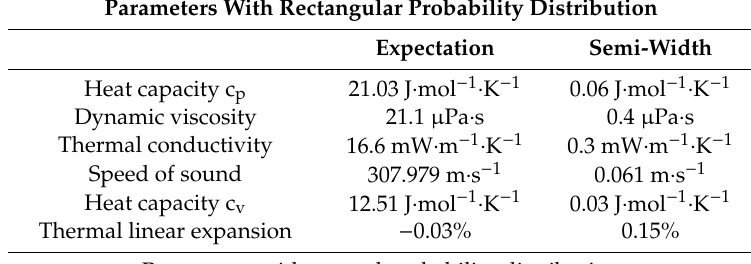
Table 1. Parameters of Equation (3) and the associated